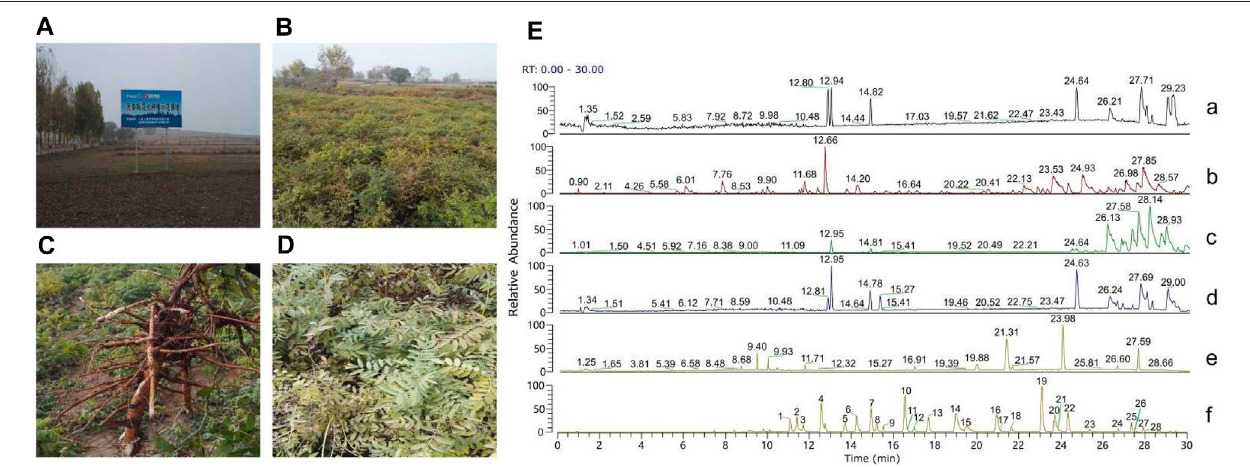
FIGURE 1 | (A) The GAP planting base (N 36 ° 33 ′ 20 ″ , E 113 ° 03 ′ 55 ″ ) of Sophora fl avescens Aiton. (B) Fields for planting S. fl avescens Aiton. (C) The root morphologyof S. fl avescens Aiton. (D) Theleafmorphologyof S. fl avescens Aiton. (E) Totalionchromatogramsof (a) blankplasma, (b) plasmasampleafter45 minSFE administration, (c) blank urine, (d) urine sample for 0 – 24 h after SFE administration, (e) SFE, and (f) standard references.